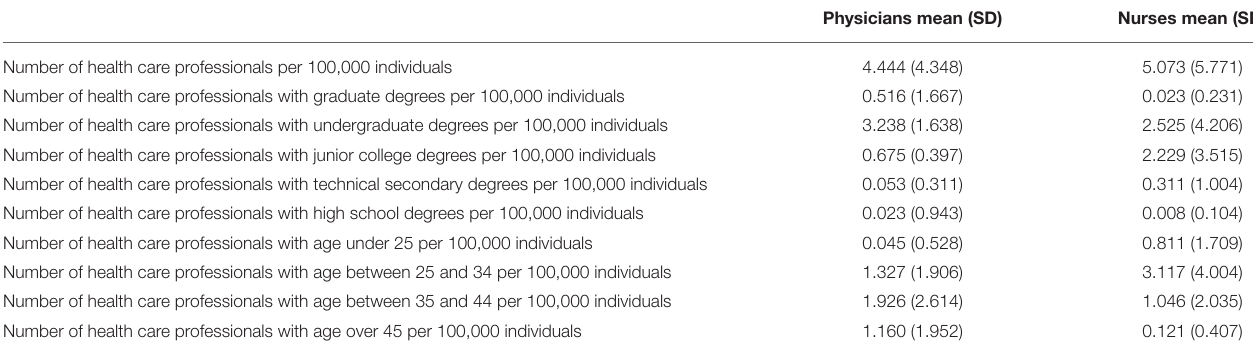
TABLE 2 | District-level characteristics of health care professional.